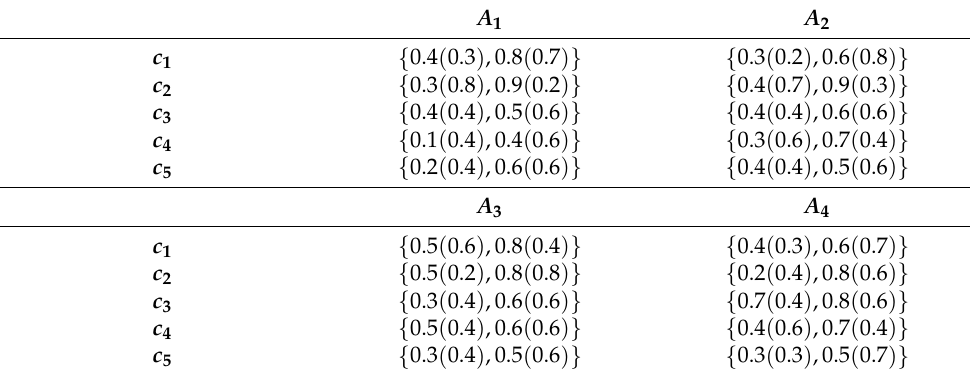
Table 3. Original evaluation matrix of Expert 3 ( d 3